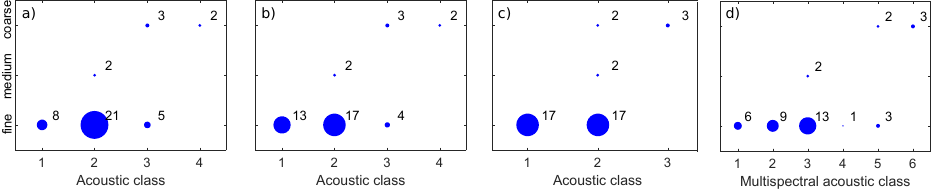
Figure 17. The grab samples (fine, medium, and coarse) with ACs and MACs obtained from the single and multispectral Bayesian method at Patricia Bay: ( a ) 100, ( b ) 200, and ( c ) 400kHz and ( d ) combined. The numbers indicate how often the categorized grab samples (see Figure 1b) are represented by a specific AC or